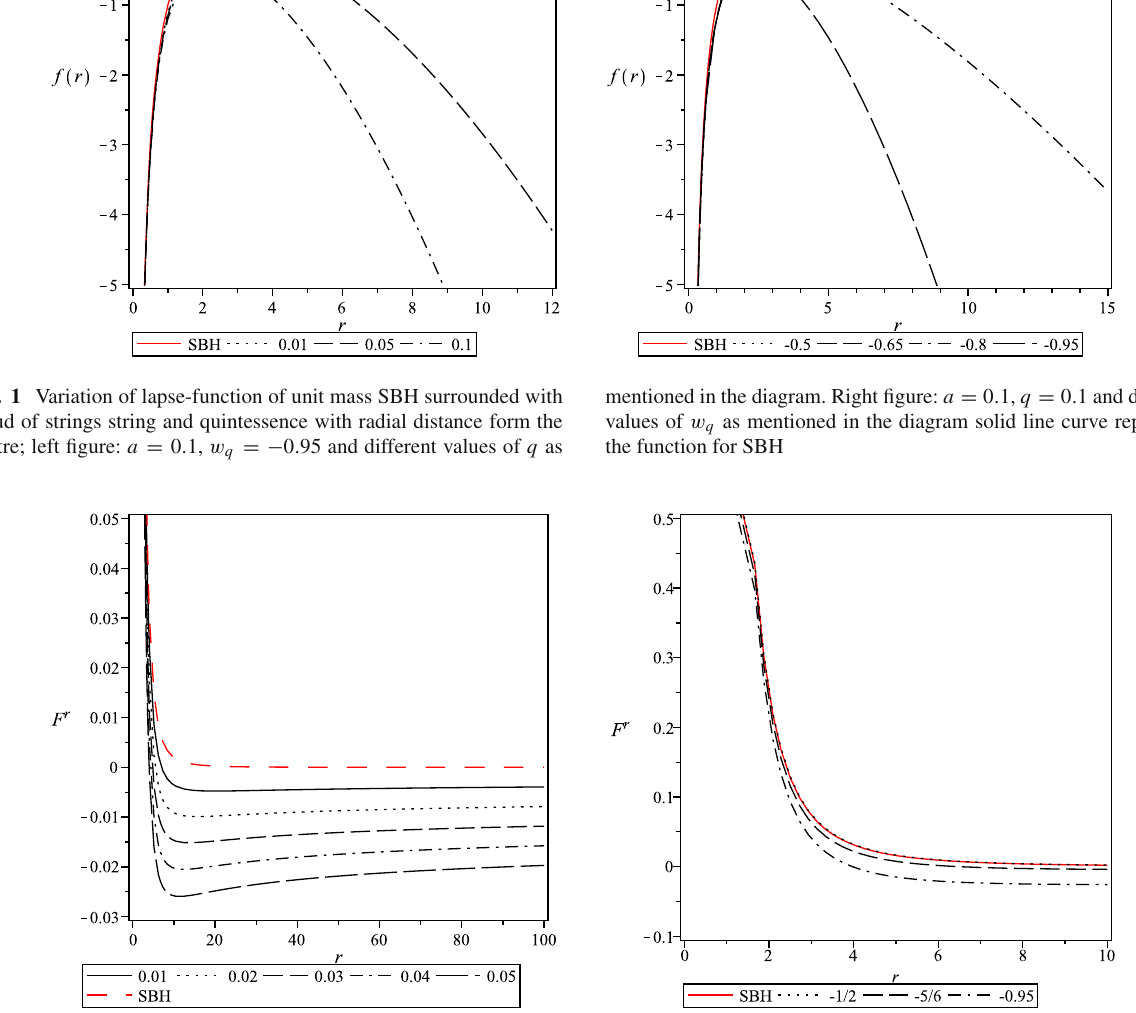
Fig. 2 Variation of radial tidal force of a unit mass SBH surrounded with cloud of strings and quintessence with radial distance from centre, left figure: w q = − 0 . 95 and different values of q as mentioned in the diagram. Right figure: q = 0 . 05 and different values of w q as mentioned in the